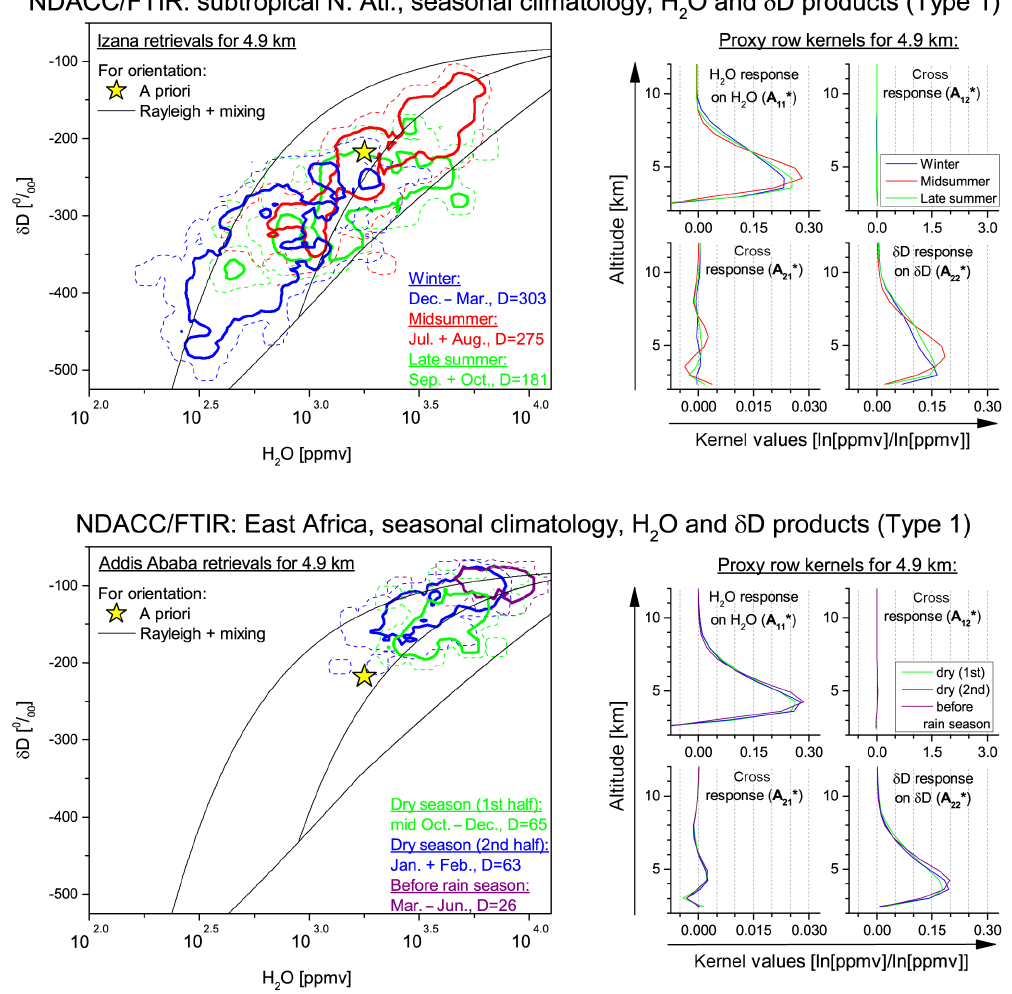
Figure 11. Same as Fig. 8, but instead of the {H 2 O, δ D} pair product (a posteriori corrected product), the plots are for the direct H 2 O and δ D retrieval output (Type 1, no a posteriori correction). Please note the different scale on the x axis of the row kernel plots compared to Fig.